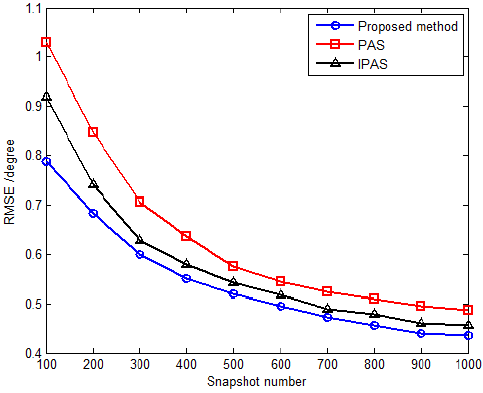
Figure 9. RMSE versus snapshot number for coherent sources with fixed SNR 15 dB.